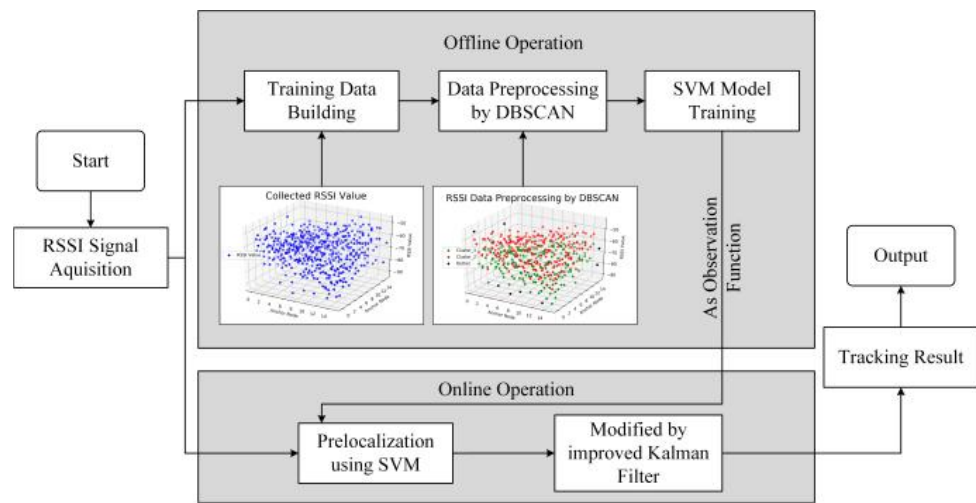
Figure 1. Structure of our algorithm.